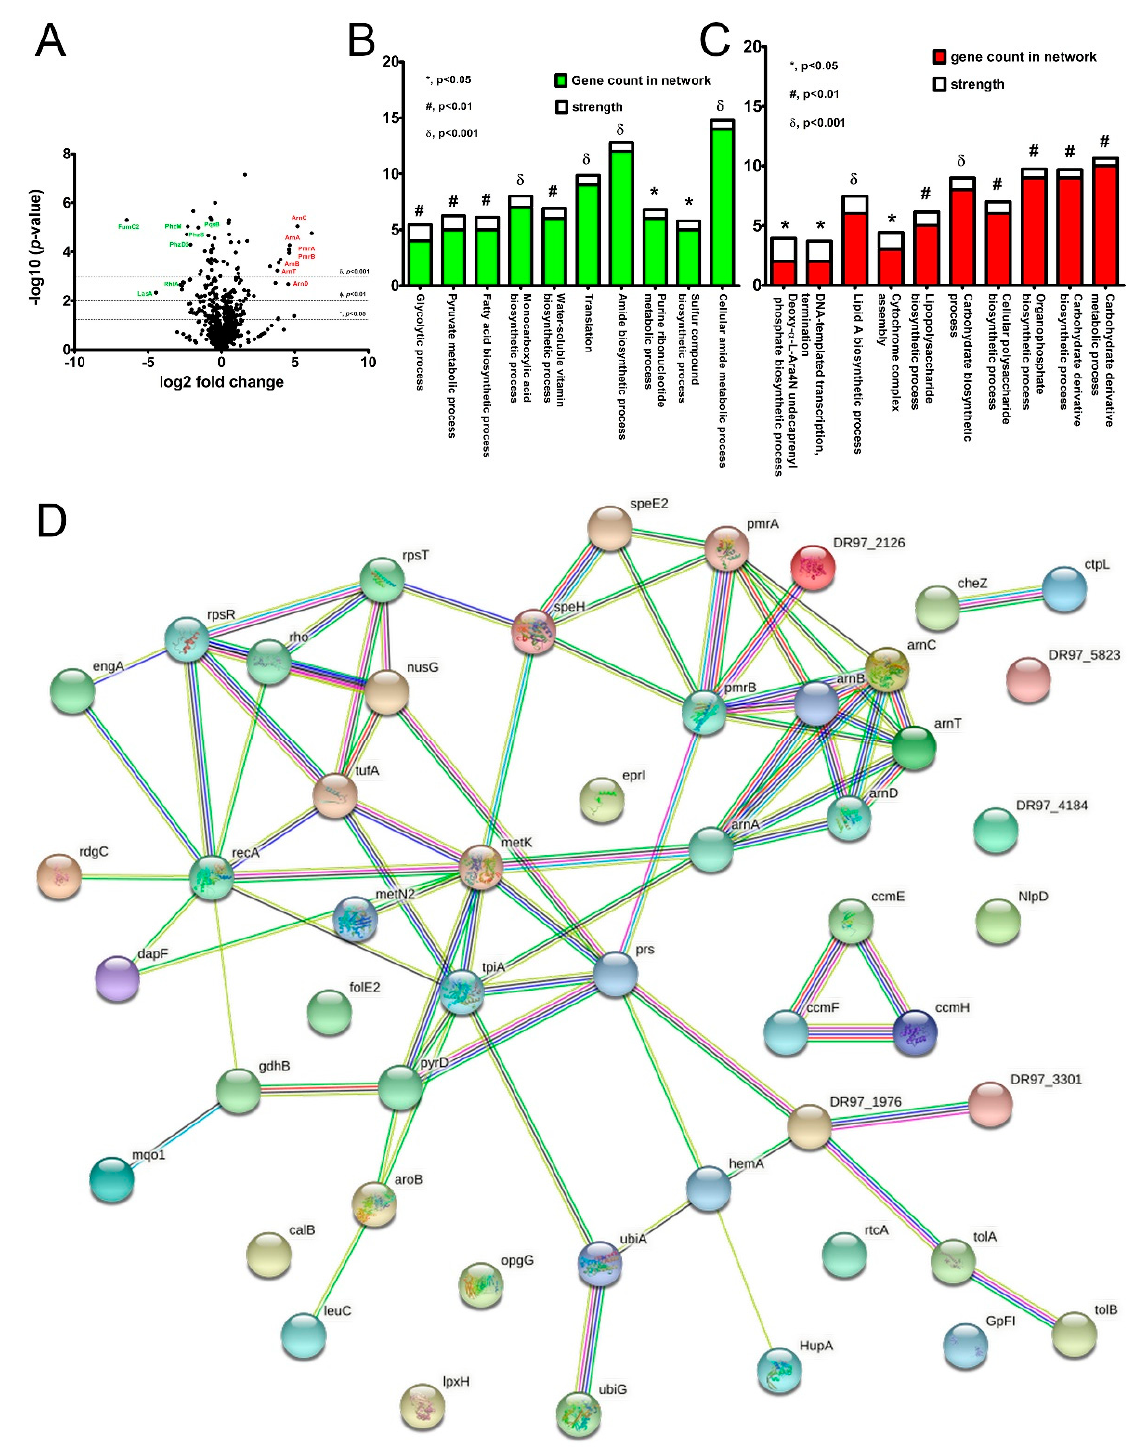
Figure 2. Proteomic study of the biofilms from P. aeruginosa parent strain (PACL) and Chlorhexidine (CHG)-treated strain (C_PACL). The volcano plot displayed the distribution of 957 proteins in which the protein abundance (log 2 fold change of C_PACL/PACL) plotted with the significant values (-log 10 p -value) ( A ). Proteins in the biological process that downregulated ( B ) and upregulated ( C ) in C_PACL compared to PACL ( p < 0.01) using STRING v.10 are demonstrated. The functional protein association networks ( D ) for the complicated connection of upregulated proteins ( p < 0.01) by STRING v.10 are also